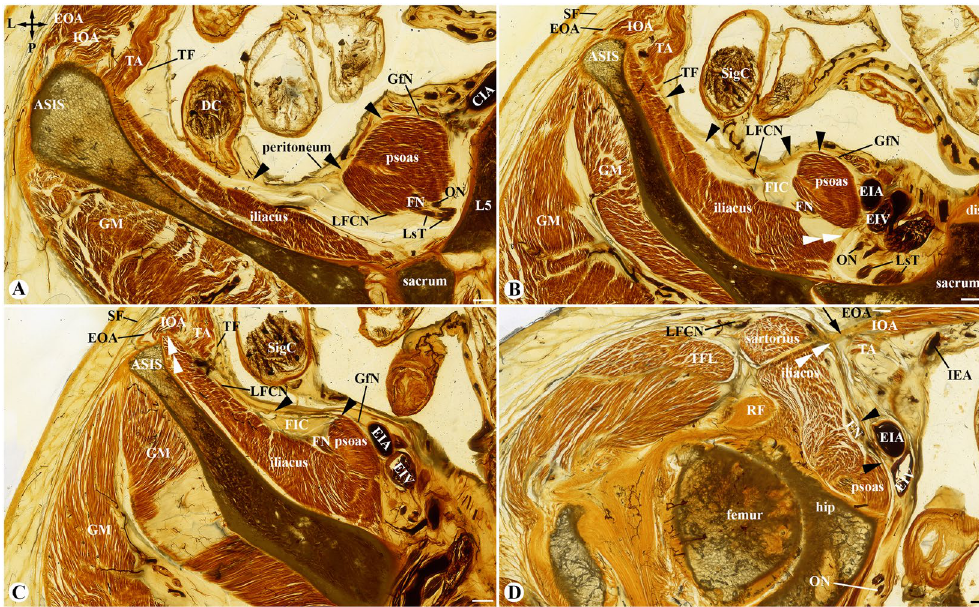
Figure 4. The fascia iliaca compartment on four adjacent transverse sections above the inguinal ligament. ( A ) A section at the 5 th lumbar vertebral level (L5) showing that the peripheral fascicular aponeurotic sheet (single arrowheads) of the psoas anchors at the descending mesocolon (DC) borders the paravertebral areolar gutter which contains the femoral nerve (FN), lateral femoral cutaneous nerve (LFCN), obturator nerve (ON) and lumbosacral trunk (LsT) and communicates anteriorly with the extraperitoneal areolar space which is medial to the epimysium of the iliacus and posterior to the transversalis fascia (TF). ASIS: anterior superior iliac spine; CIA: common iliac artery; GfN: genitofemoral nerve; EOA: external oblique abdominis; IOA: internal oblique abdominis; TA: transversus abdominis; GM: gluteal muscle. ( B ) An adjacent section 3.4 cm inferior to ( A ) showing that the peripheral fascicular aponeurotic sheet (single arrowheads) of the psoas forms the fascia iliaca and borders the fascia iliaca compartment (FIC) which contains the FN and LFCN, but not the ON and GfN. Double arrowheads point to a membrane-like structure separating the FIC from the paravertebral gutter. EIA/EIV: external iliac artery and vein; disc: 5 th lumbar intervertebral disc; SF: Scarpa’s fascia; SigC: sigmoid colon. ( C ) An adjacent section 2 cm inferior to ( B ) showing that the internal oblique abdominis (IOA), transversus abdominis (TA) and transversalis fascia (TF) fuse with aponeurotic fibers of the iliacus, forming a conjoint tendinous sheet (double arrowheads) of the fascia iliaca (single arrowheads). ( D ) An adjacent section 4 cm inferior to ( C ) showing that the conjoint tendinous sheet (double arrowheads) of the fascia iliaca (single arrowheads) below the ASIS is strengthened by the inferior prolongation of the inguinal ligament (single arrow), and the fascia lata over the sartorius. Crossed-arrows: orientation of the figure (L: lateral; P: posterior). Bars = 5